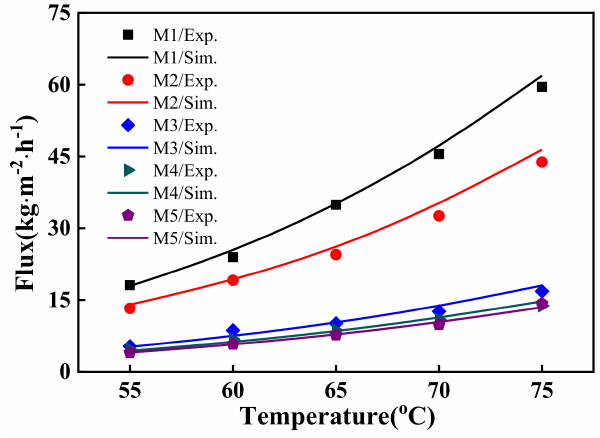
Figure 1. Comparison between the experimental and the predicted water flux.